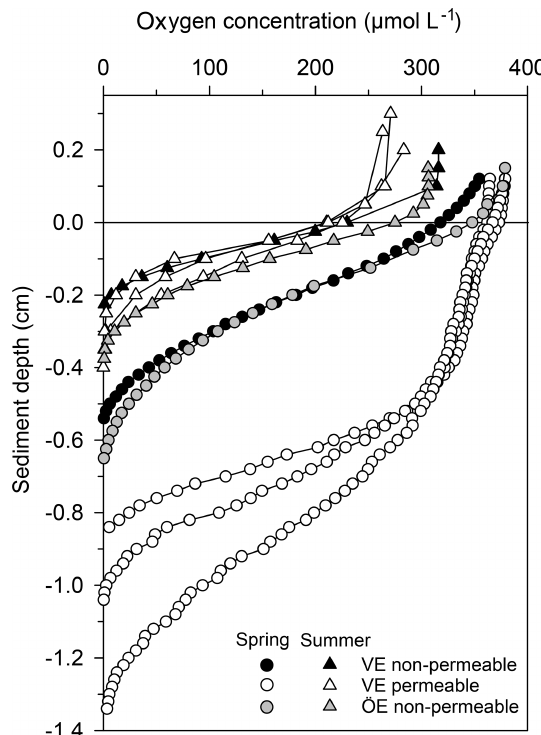
Figure 5. Pore-water oxygen concentration profiles in the perme- able ( n = 3) and non-permeable ( n = 1) sediments of representa- tive stations of the Vistula Estuary (VE) and in the sediments of the Öre Estuary (ÖE, n = 1) in spring and summer. Profiles of the Öre Estuary are reproduced from Hellemann et al. (2017); please note that no permeable sediment exists in the Öre Estuary. The zero line indicates the sediment